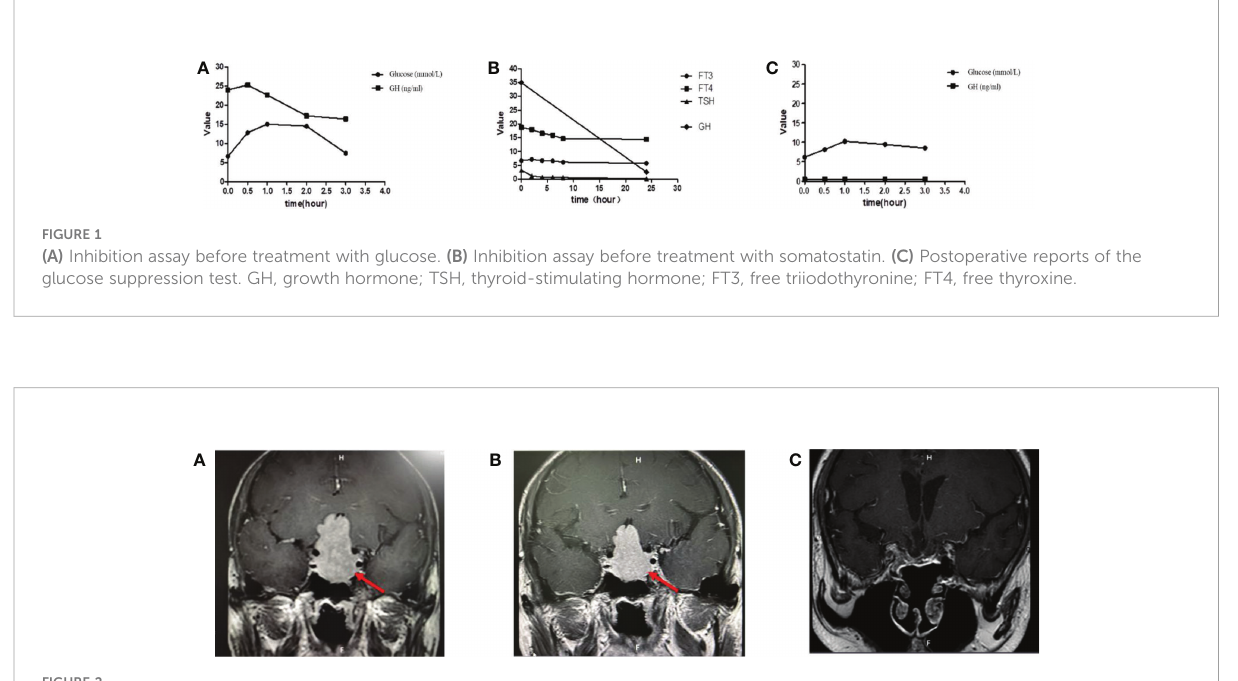
FIGURE 2 (A) Pituitary MRI before treatment: a large mass of equal T1, slightly longer T2 signal foci in the saddle area, clear boundaries, about 2.6 × 2.7 × 4.7 cm in size, protruding upward into the suprasellar cistern, semi-enveloping the internal carotid arteries on both sides, and the optic chiasm pressured upward. (B) Pituitary MRI after 6 months of octreotide: similar to that before treatment. (C) Pituitary MRI 9 months after